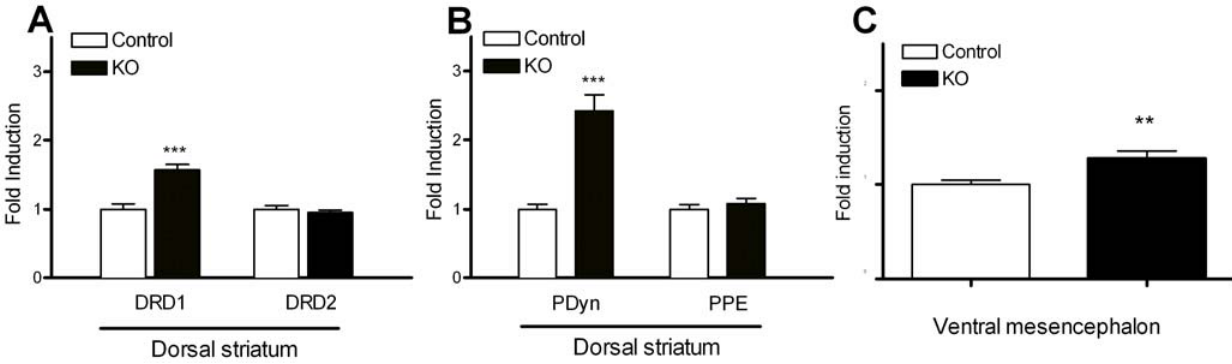
Figure 5. Pten ablation in DA cells affect the direct striatal output system by significantly increasing mRNA expression levels for DRD1 and pDyn in striatal medium spiny neurons. BDNF mRNA levels were significantly elevated in the ventral mesencephalon (A) Dopamie receptor D1 (DRD1) and D2 (DRD2) mRNA expression levels in the striatum of control (n=9) and Pten KO animals (n=13). DRD1 mRNA expression levels were significantly increased in KO animals as compared to controls. DRD2 mRNA levels were unchanged between the groups. (B) Changes in DRD1 expression levels were accompanied by an elevation in prodynorphin (pDyn) mRNA in Pten KO animals. Preproenkephalin (PPE) mRNA expression levels were unchanged. (C) BDNF mRNA levels were significantly increased in the ventral mesencephalon in KO animals. All data are mean 6 SEM. *p , 0.05, Student’s t-test.